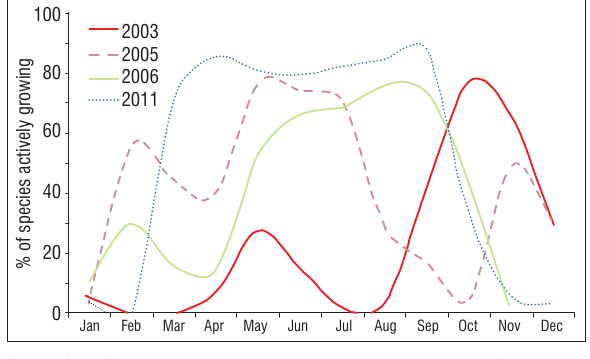
Figure 1: The percentage of species ( n =70) with evidence of new shoot growth (i.e. actively growing) in each month in 4 different years in